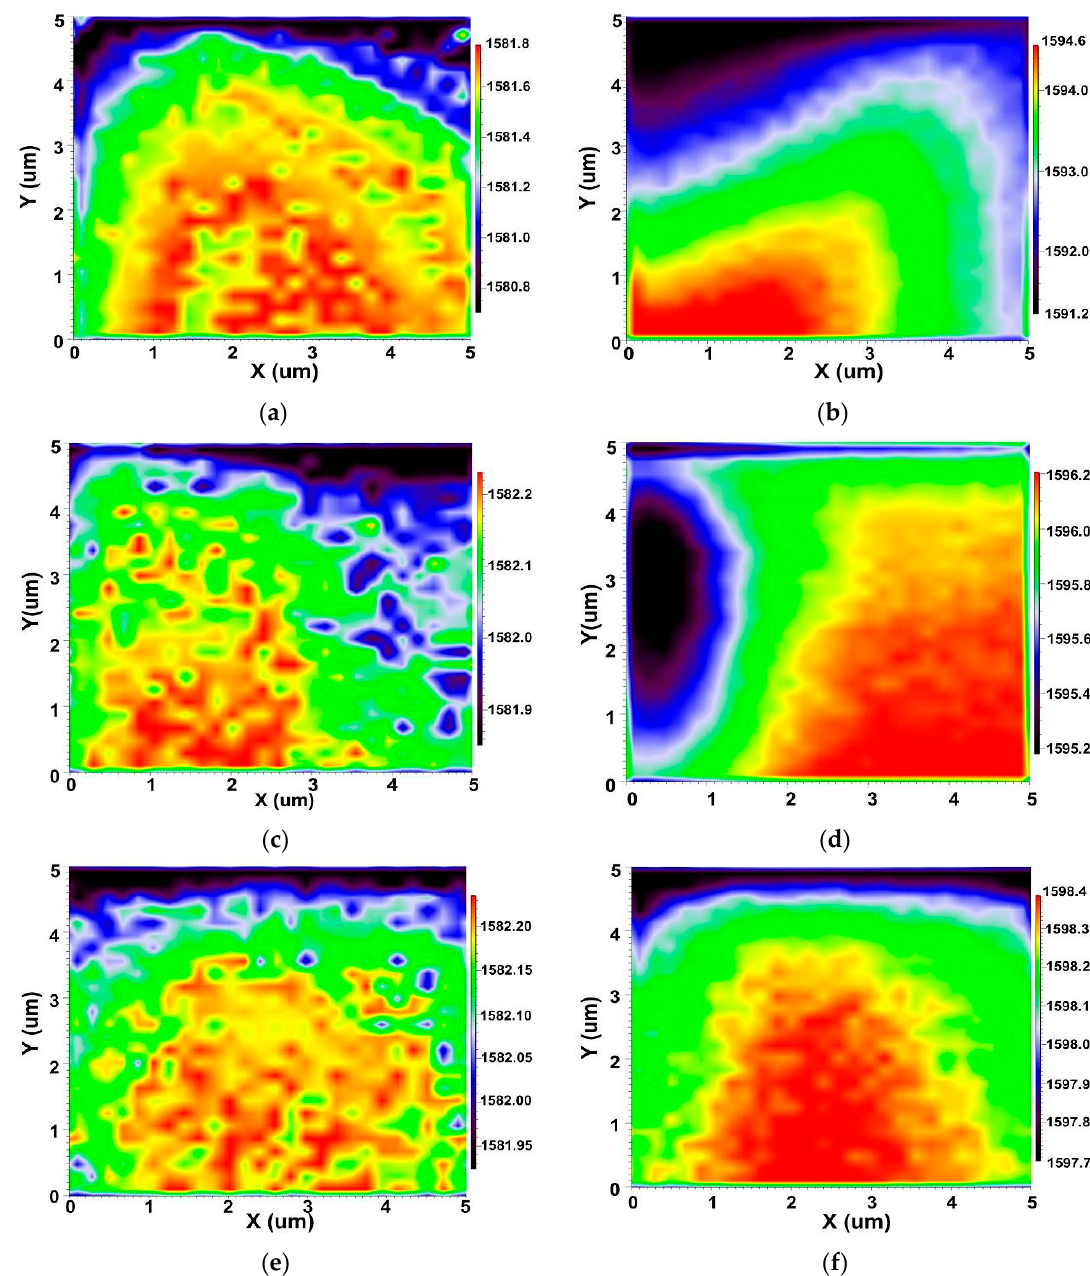
Figure 9. Raman mapping of G band of ( a ) MWCNT-NH 2 /epoxy nanocomposites, ( b ) MWCNT-NH 2 /epoxy nanocomposites with 1% bending load, ( c ) MWCNT-BuGE/epoxy nanocomposites, ( d ) MWCNT-BuGE/epoxy nanocomposites with 1% bending load, ( e ) MWCNT-BeGE/epoxy nanocomposites and ( f ) MWCNT-BeGE/epoxy nanocomposites with 1% bending load. Color-code: quantities related to MWCNTs are given in color, those of the epoxy matrix—in black.